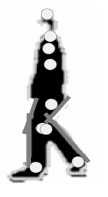
Figure 5: The nine points (in white) and linear re- gressions (grey line).